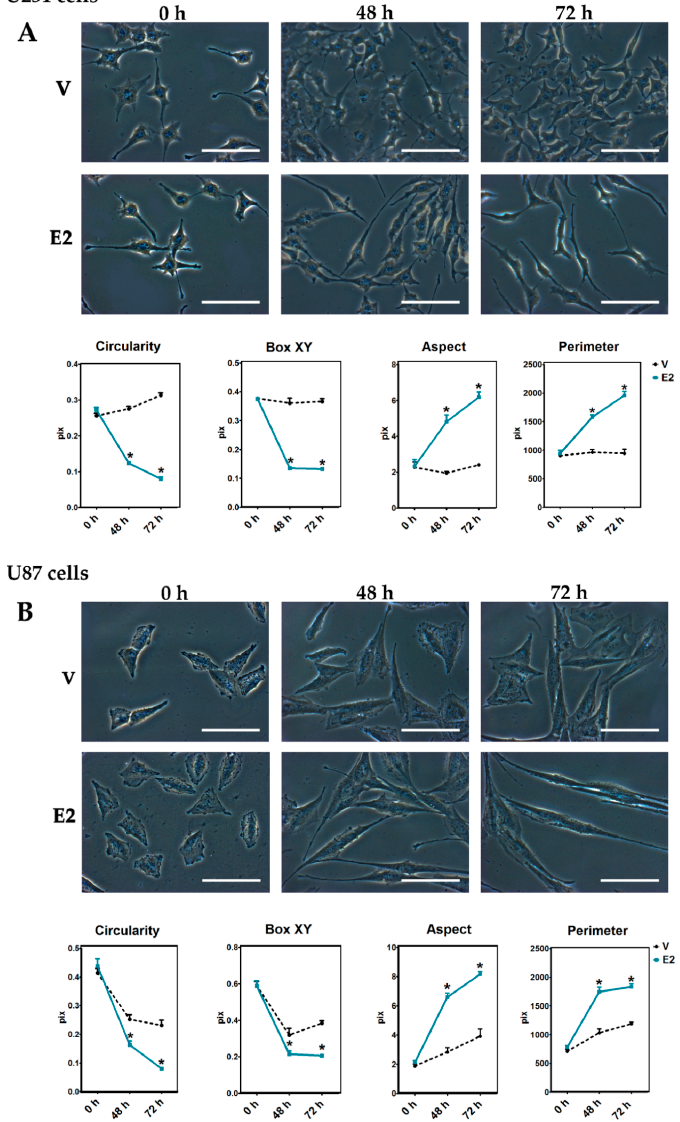
Figure 2. 17 β -Estradiol (E2)-induced morphological changes in human GBM-derived cells. ( A ) U251 and ( B ) U87 cells observed by phase-contrast microscopy with a magnification of 400 × at 0, 48, and 72 h after adding 17 β -estradiol (E2, 10 nM) and the vehicle (V, 0.01% cyclodextrin). Magnification white bar = 100 µ m. Plots represent the quantification of the geometric parameters (circularity, box XY, aspect, perimeter) in this study. Results are expressed as the mean ± standard error of the mean (SEM); n = 3; * p < 0.05 vs.